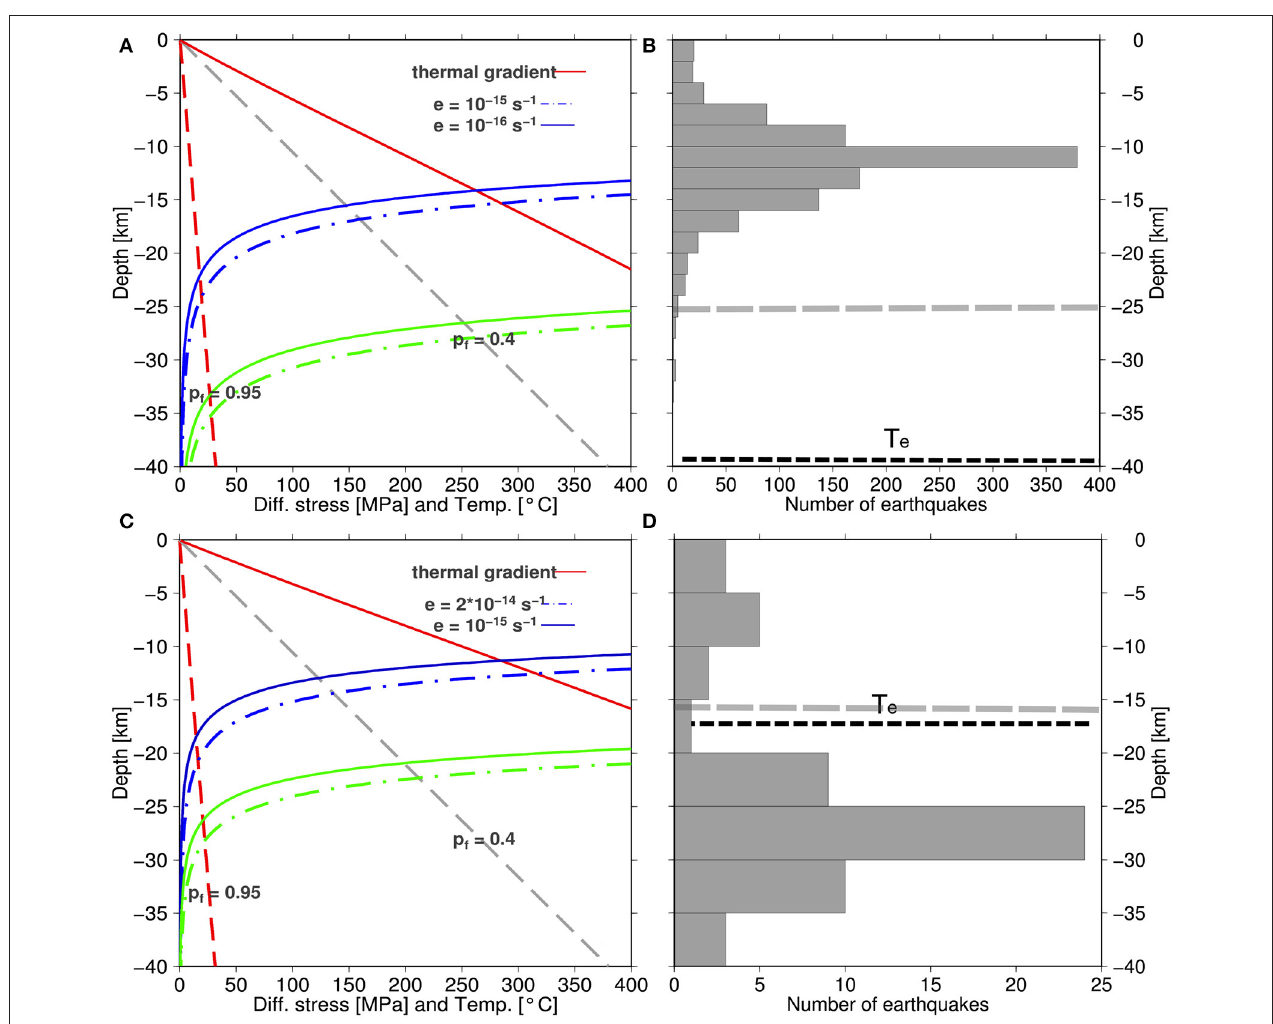
FIGURE 4 | Yield Strength Envelope (YSE) and seismicity in the NW plateau ( A,B ; respectively) and the MER ( C,D ; respectively). There is a good match between modeled BDT and depth distribution of seismicity in the NW plateau. In the rift, there is a big mismatch between the two parameters. The seismicity is in 2 and 5 km depth bins in the NW plateau and the MER, respectively. The YSE is constructed for wet quartzite upper crust (blue lines) and mafic granulite (green lines) lower crust for both NW plateau and the MER. The p f is the pore fluid factor [0.4 for hydrostatic and 0.95 for (near-) lithostatic states shown in broken gray and red lines, respectively]. T e refers to the effective elastic thickness ( Ebinger and Hayward, 1996). The broken gray line in (B,D) is the boundary between upper and lower crust (Mackenzie et al.,